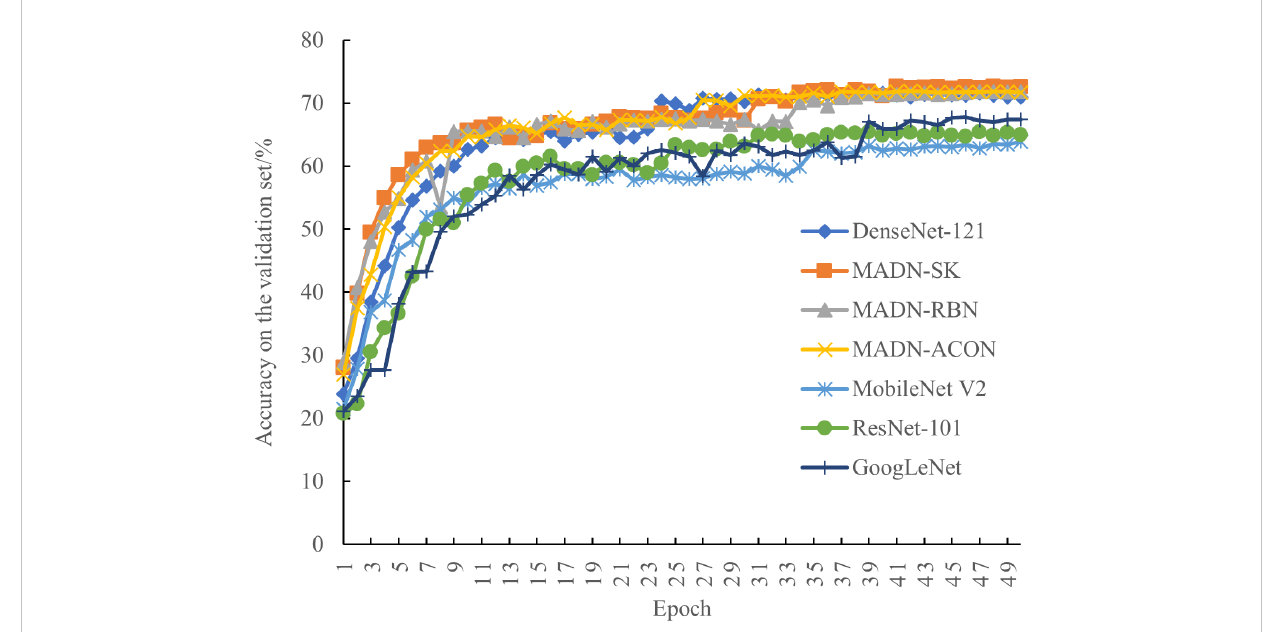
FIGURE 6 Classi fi cation accuracy of the model for each iteration on the validation